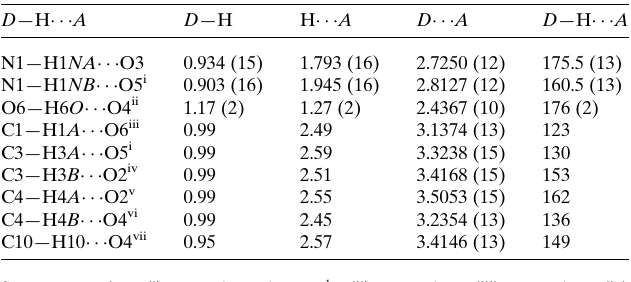
Table 1 Hydrogen-bond geometry (A˚ , (cid:4) ) for I .